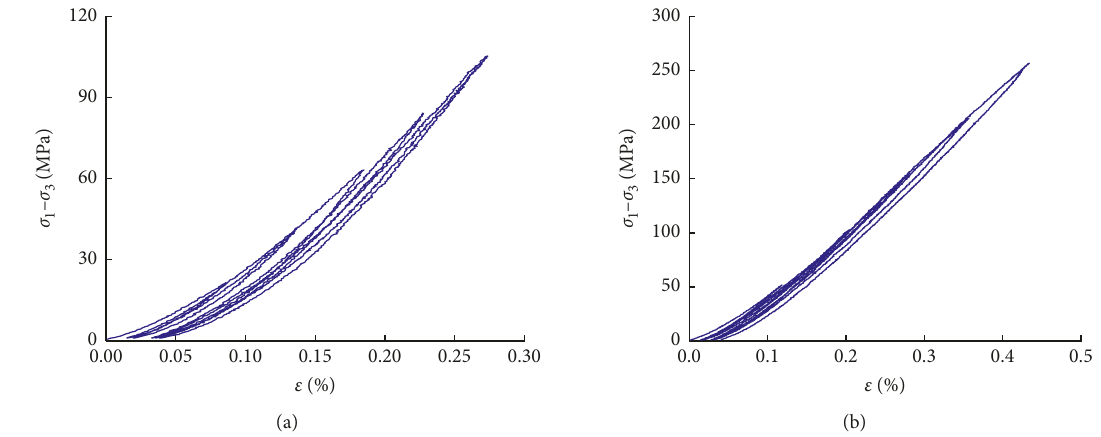
Figure 4: Comparisons of stress-strain curves during the first five cycles. (a) σ